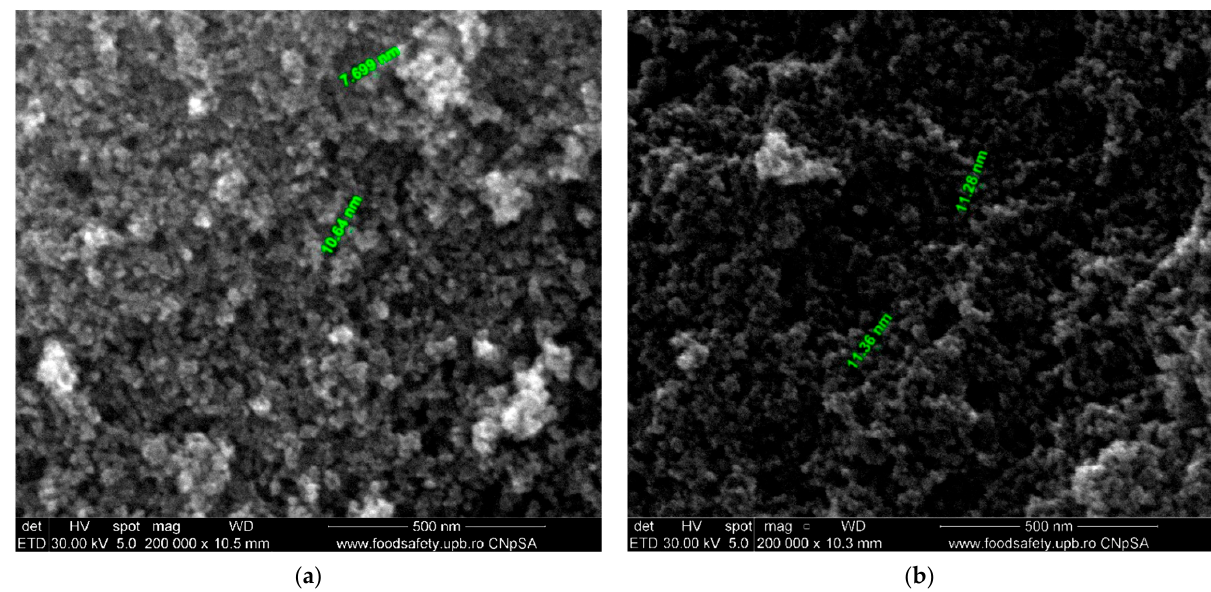
Figure 5. Scanning electron micrographs of ( a ) Fe 3 O 4 and ( b ) Fe 3 O 4 /PVA.